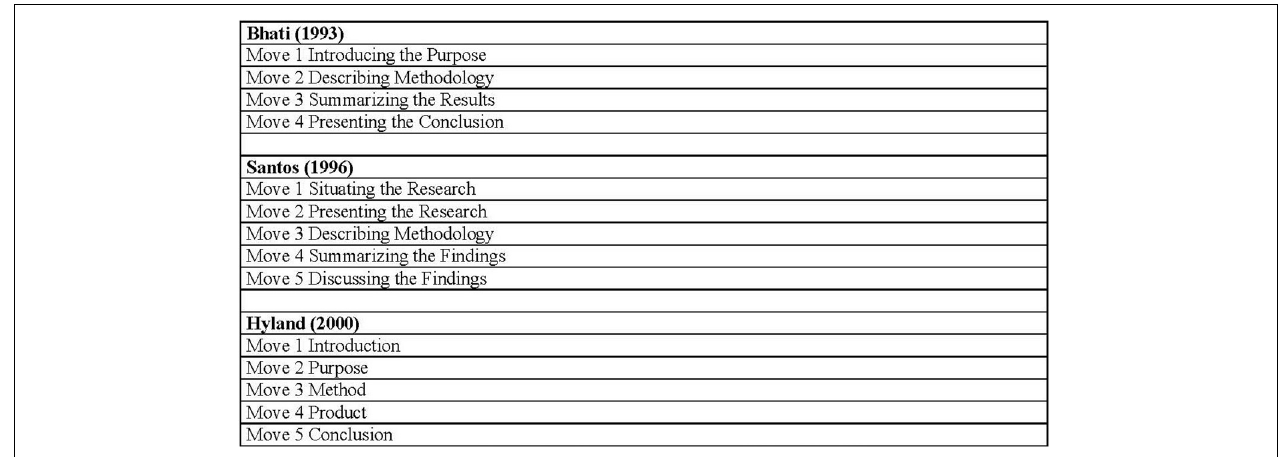
FIGURE 1 | Research article abstracts move models (El-Dakhs, 2018).